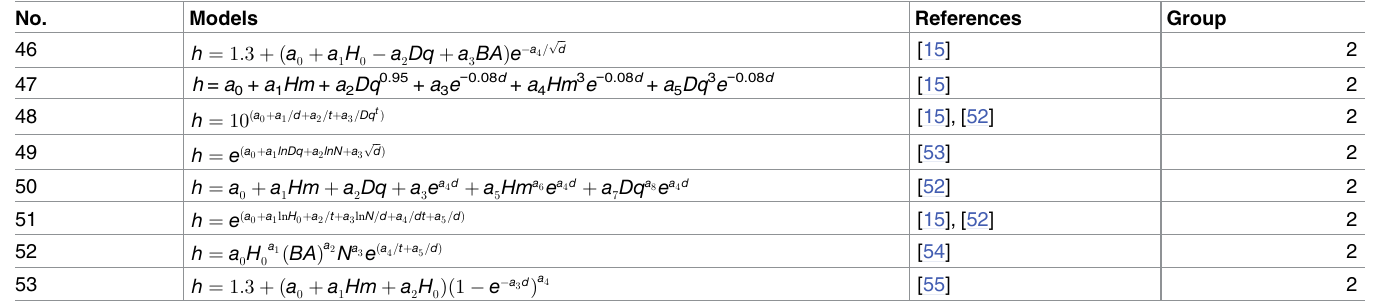
preferred)[5]. The expressions of the statistics are shown as follows: Root of mean square error RMSE ¼